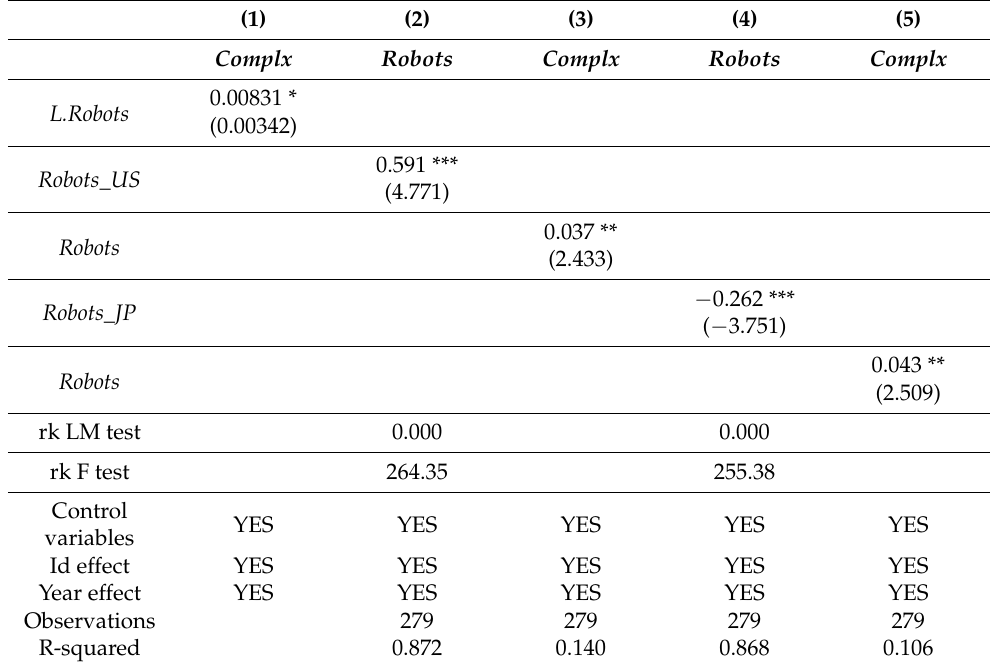
Table 4. Endogenous